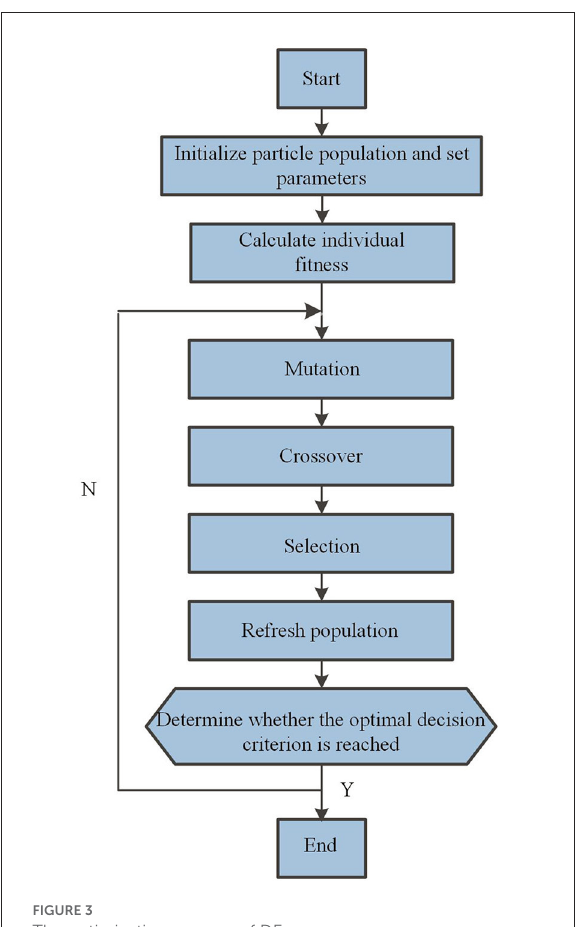
TABLE 2 Algorithm II: Conventional